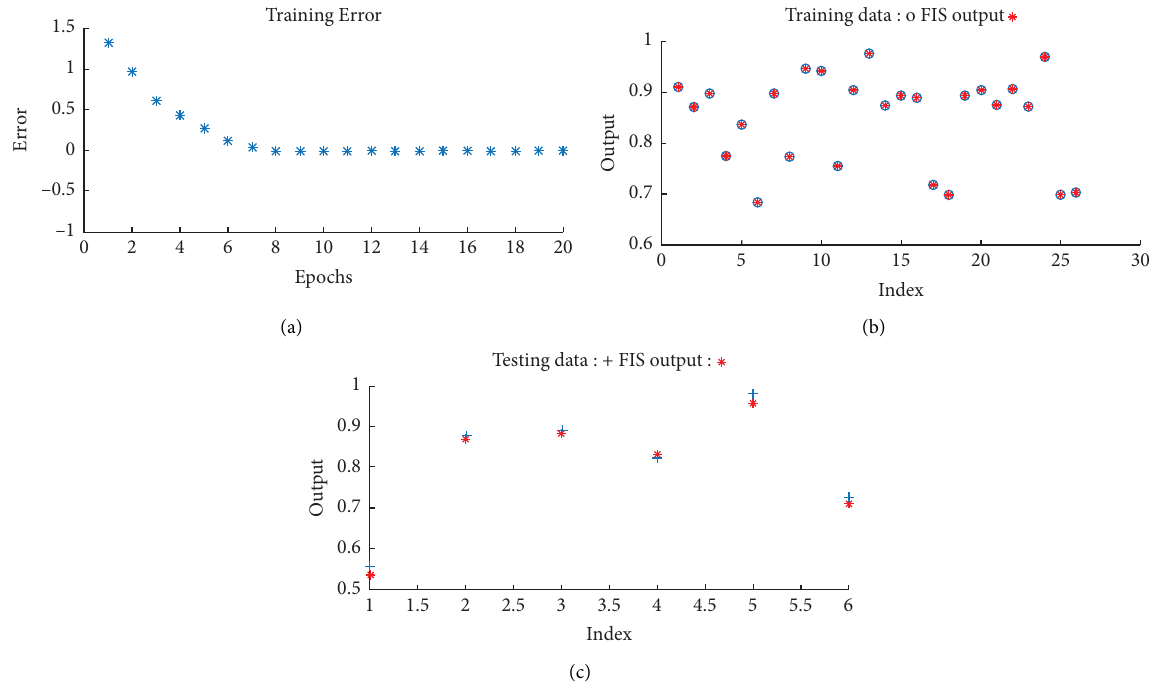
Figure 3: (a) Training error curve of the ANFIS model for ATN removal. (b) Comparison of experimental and predicted values in training. (c) Testing